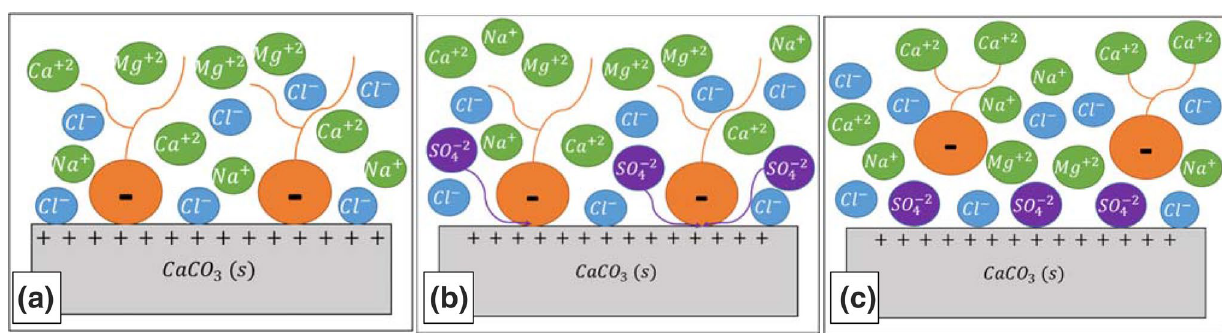
Fig. 8 a Initial ion distribution, b adsorption of sulfate ions on the rock and c release of oil ( RCOO ) 2 Ca